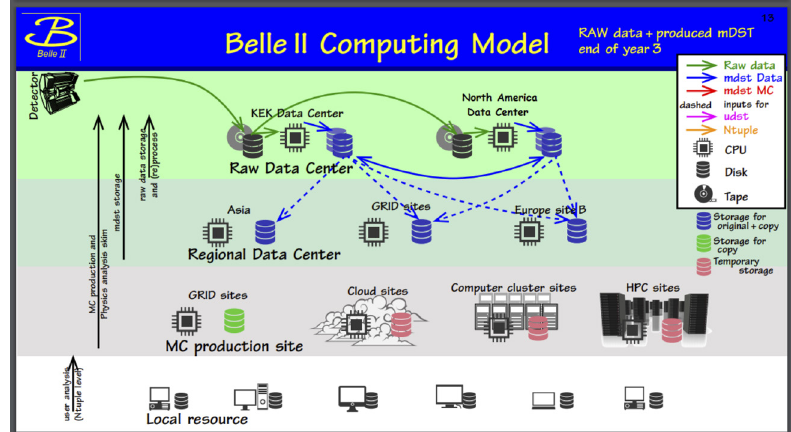
Figure 1: Belle II Computing Model for the first three years of